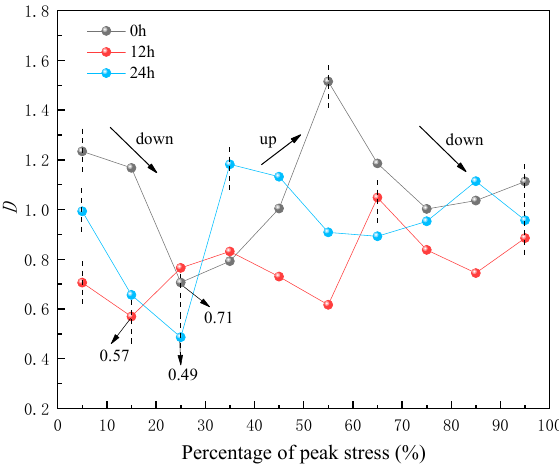
Figure 10. D of LCTB with different filling interval time.